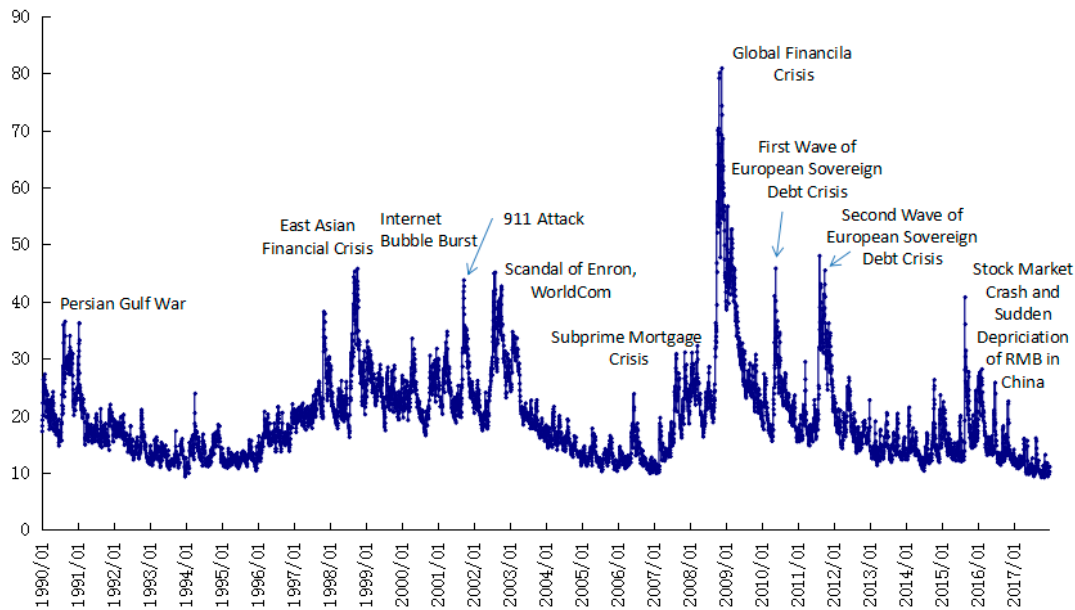
Figure 6. The evolution of VIX and corresponding incidents.